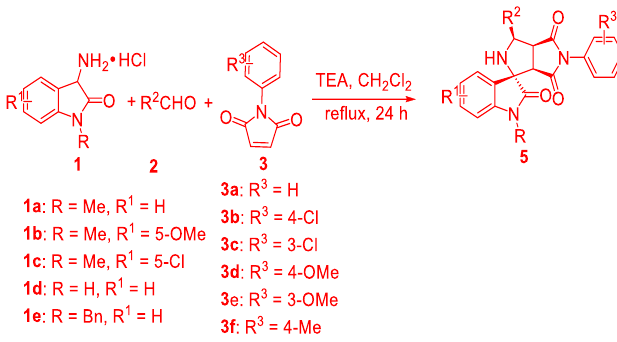
Scheme 4. Screening of a series of 3-amino oxindoles 1 and maleimides 3 . Table 3. Scope of 3-amino oxindoles 1 and maleimides 3 a .